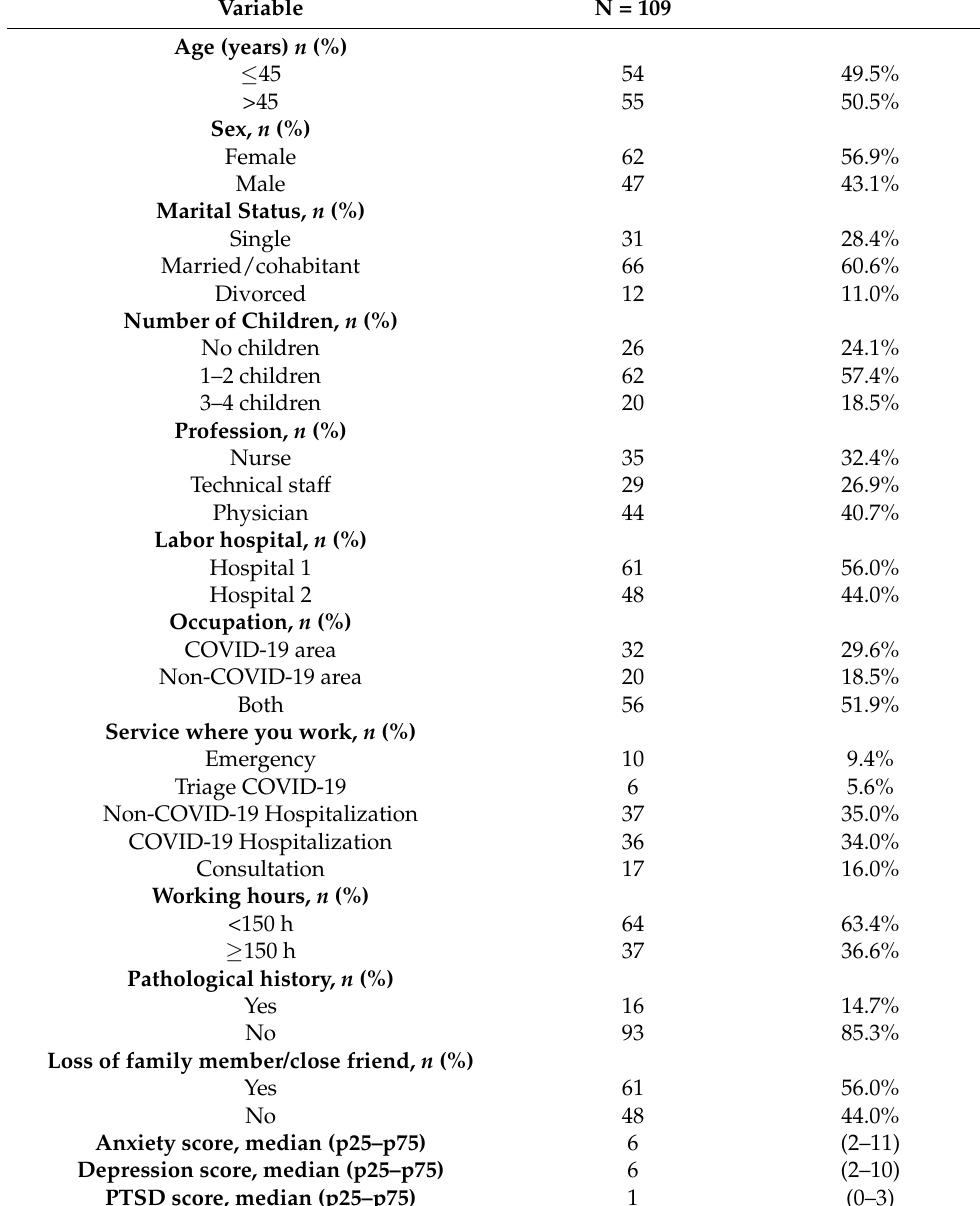
Table 1. Characteristics of the